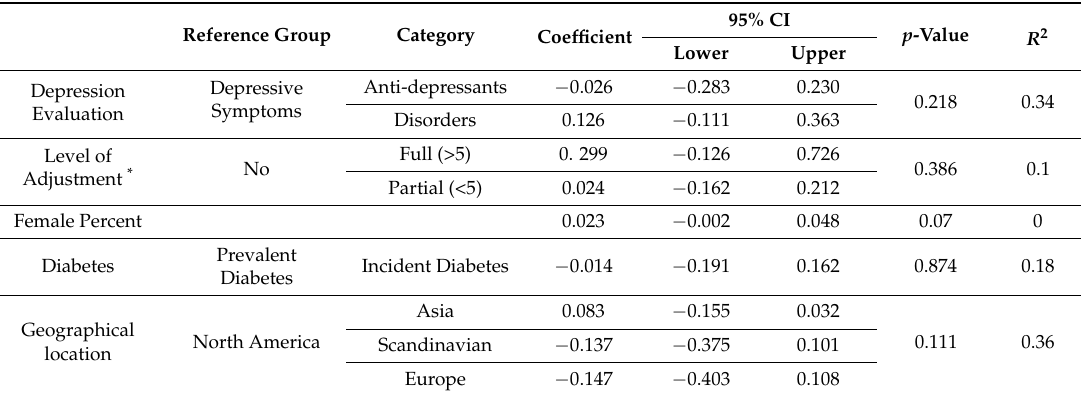
Table 5. Meta-regression for depression cohort studies.